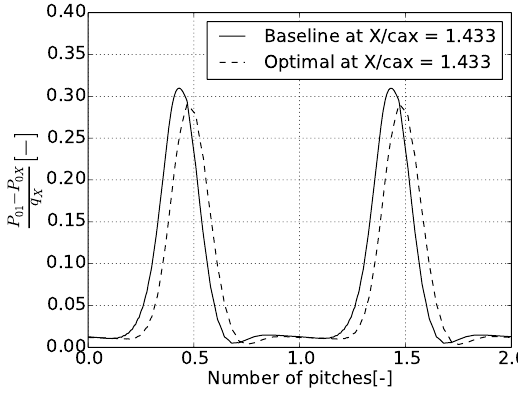
Figure 5. Total pressure loss downstream at X / c ax =